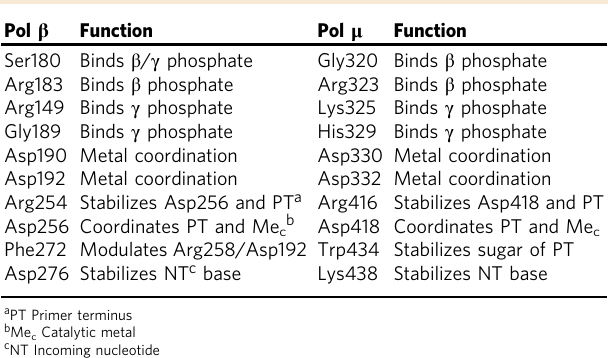
Table 2 Comparison of structurally equivalent residues involved in catalysis in pols β and